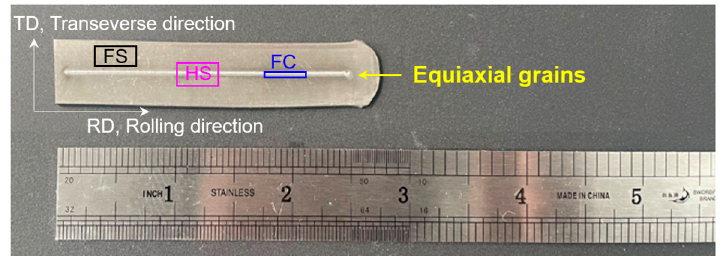
Figure 1. The plate after the welding treatment is completed, where HS, FC and FS stand for heterogeneous structure, freestanding center coarse and freestanding surface, respectively.